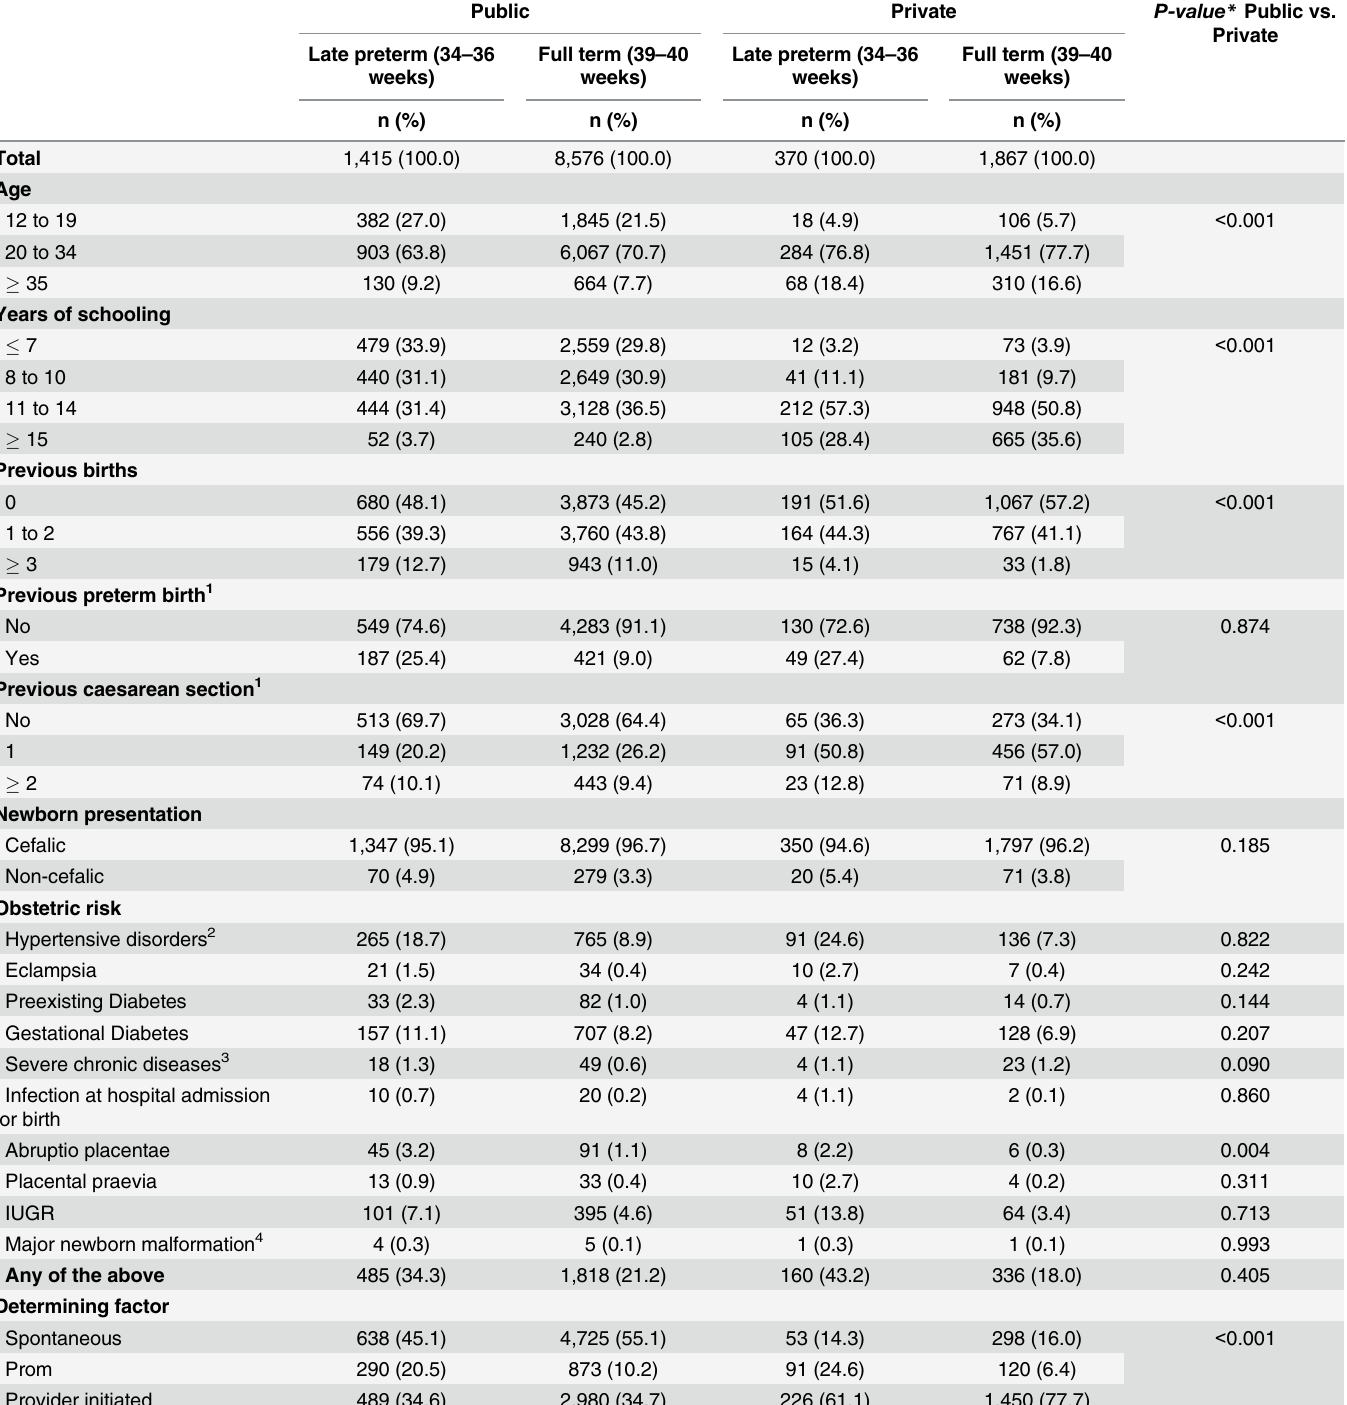
Table 1. Characteristics of women by gestational age and type of childbirth care in singleton live births. Birth in Brazil, 2011 –